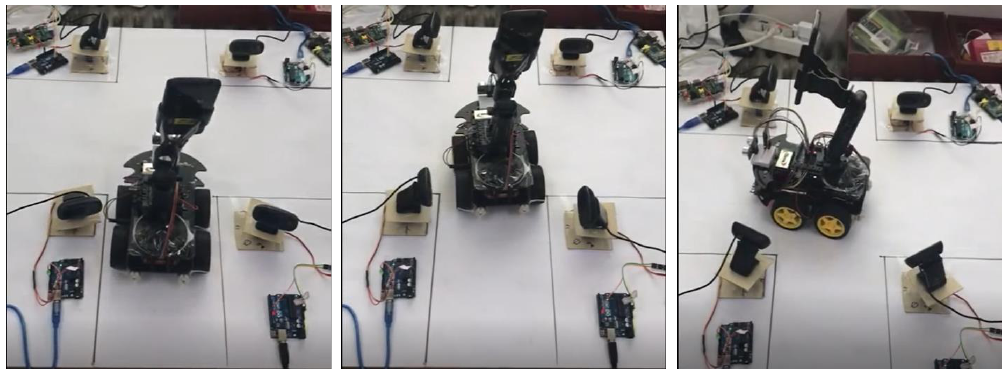
Figure 9. Demonstration of IoT collaboration between an unmanned patrol car and CCTVs .